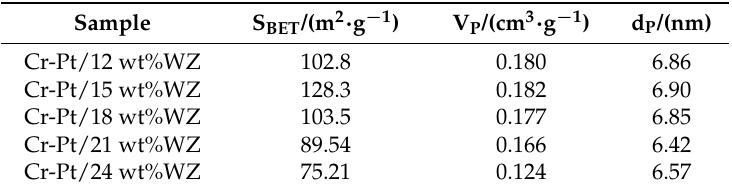
Table 2. The specific surface area and pore size and volume of the Cr-Pt/WZ catalyst with different WO 3 contents.